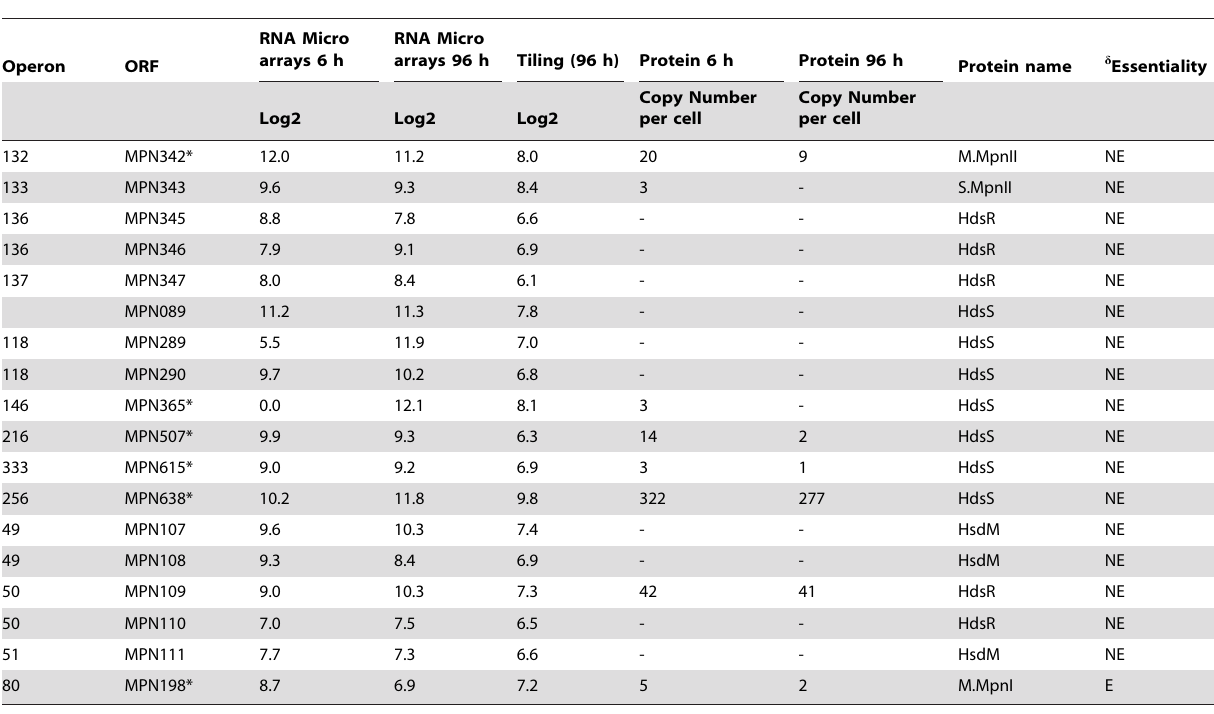
Table 1. Levels of RNA and protein for different proteins of M-R systems of M. pneumoniae .